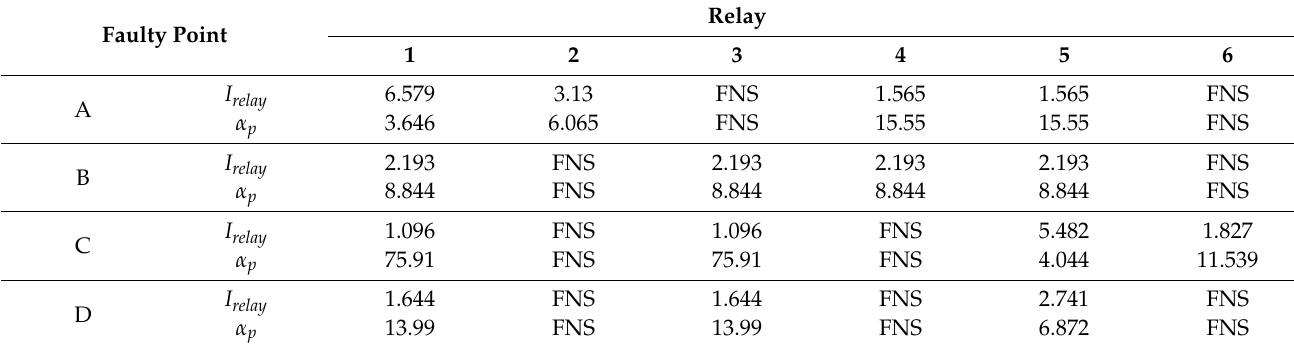
Table 12. Plug settings (PS) and CT ratios of the relays (Case